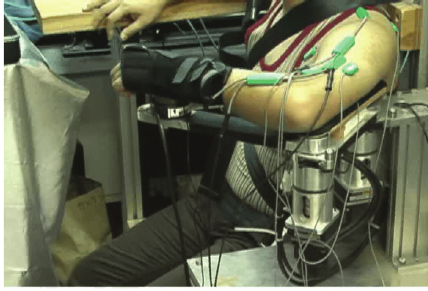
Figure 2: Appearance of experiment.